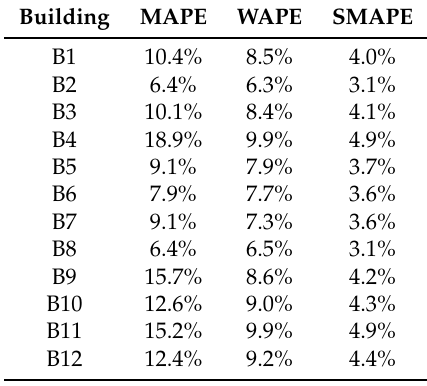
Table 1. Prediction error for each building: ridge regression model, time frame: 5–10